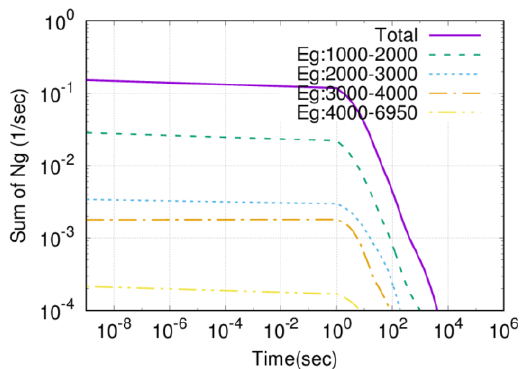
Fig. 7. Integral of BDFG over variant energy regions as functions of the decay time for n th + 241 Pu fission. Table 1. BDFG Coefficients (>0.01) of n+ 241 Pu